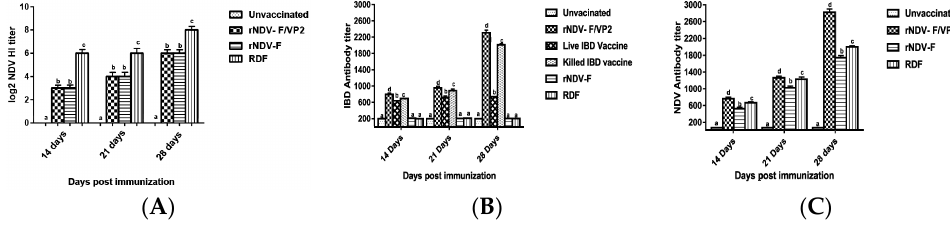
Figure 5. NDV and IBDV specific serum antibody responses in the experimental chickens. ( A ) HI assay was carried out 14 and 28 days post-immunization. All HI titers are expressed as mean reciprocal log2 titre ± SEM (standard error of the mean) (n = 10). Statistical differences were calculated by one-way ANOVA with p < 0.01 and Waller-Duncan as post-hoc test. The antibody titers as determined on 14, 21 and 28 days post-immunization by ELISA, ( B ) higher than 500 were considered positive for IBDV antibody and ( C ) higher than 200 were considered positive for NDV. Data represent the mean ± standard error. Statistical analysis was done by one-way ANOVA ( p < 0.01 and Waller-Duncan as post-hoc test. Level not connected by same letter are significantly different ( p < 0.01).